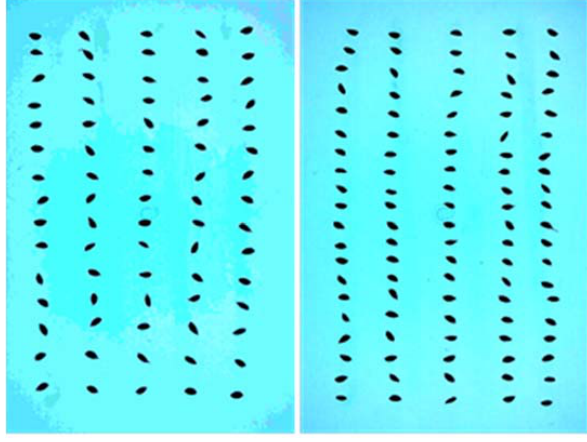
Figure 3. Sample image used to calculate the average area of each rice grain.